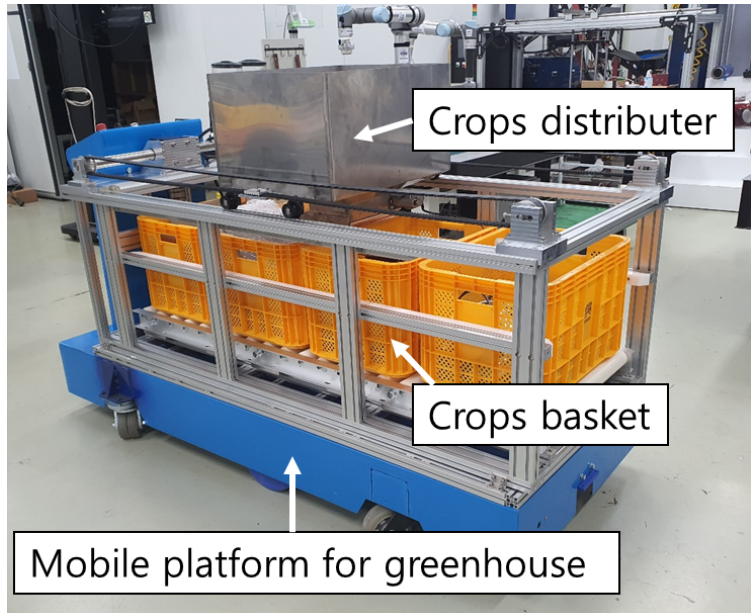
Figure 5. Developed transporting robot with four carrying